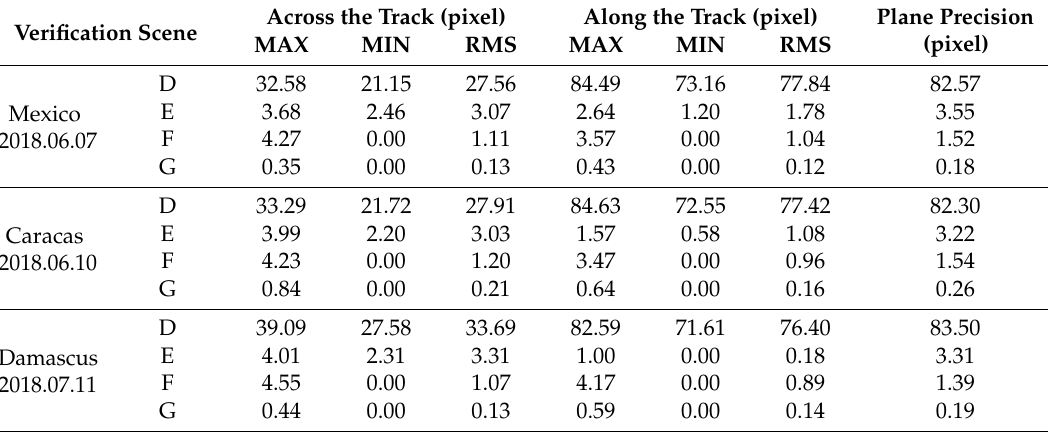
Table 6. Accuracy of verification